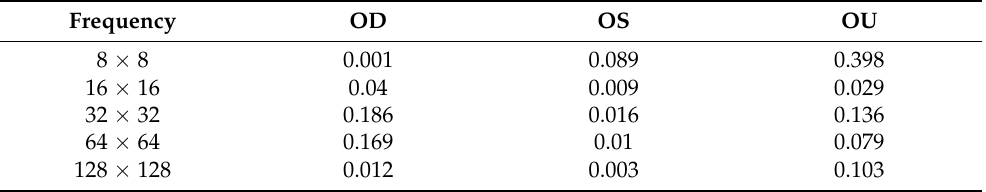
Figure 2. Display of mean visual evoked potentials (VEPs) values for oculus dexter (OD), i.e., right eye, oculus sinister (OS), i.e., left eye, and oculus uterque (OU) both eyes for mTBI ( a ) and controls ( b ). Significance thresholds designated at: ** = p < 0.01, *** = p < 0.003. The VEP P1 mTBI mean p -values (7.8 ± 0.5–16.3 ± 4.0) are within a very wide range of values, as seen in Table 3. All of the VEP mean values for the controls are within the 9.1 ± 0.8–12.27 ± 1.2 range.